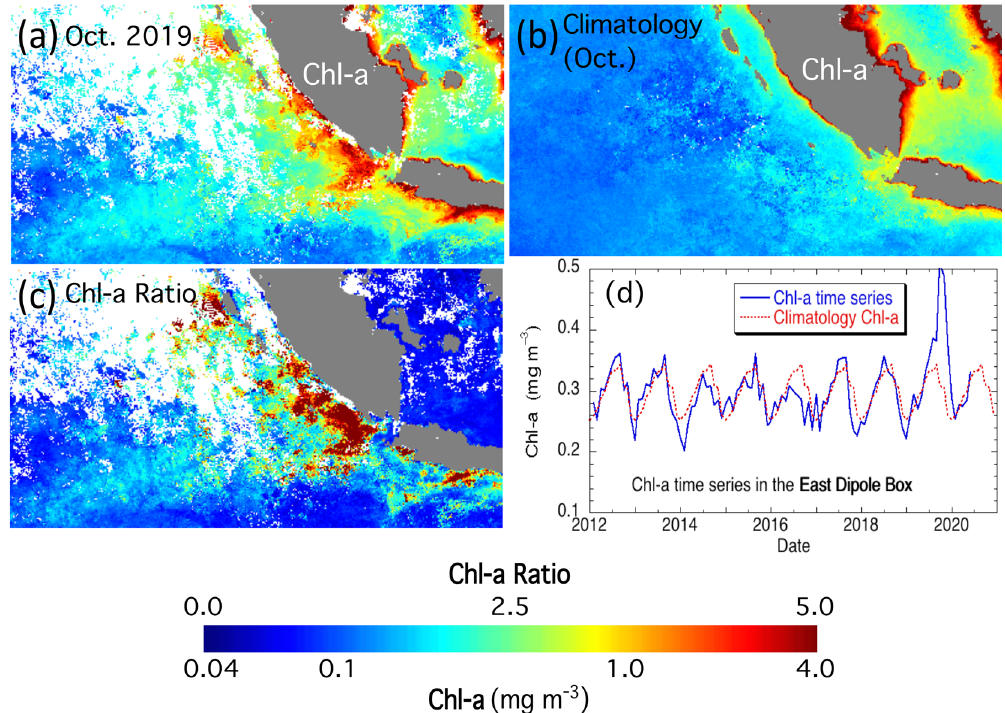
Figure 2. ( a ) Chl-a in October 2019, ( b ) Chl-a climatology in October, and ( c ) the ratio of Chl-a in October 2019 and climatology Chl-a in October in the east IOD zone. ( d ) Time series of the average Chl-a between 2012 and mid-2020 in the east IOD zone. The seasonal climatology average Chl-a is shown as a dashed line for